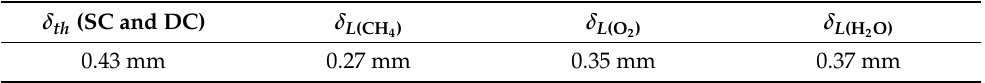
Table 5. Different flame